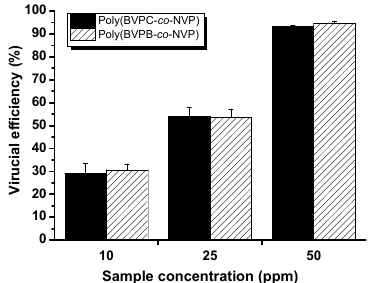
Figure 6. Virucidal efficiency of poly(BVPC- co -NVP) and poly(BVPB- co -NVP) against influenza virus. The result of plaque assay indicated quaternized pyridinium-type polyvinylpyrrolidone possessed highly antiviral activity against influenza virus. According to the foregoing analysis of structure of enveloped virus, the antiviral mechanism of prepared polymers was deduced to be similar to their antibacterial mechanism. The proposed sequence of events with influenza virus exposed to polycations is schematically illustrated in Figure 7. Polycations adhered to influenza virus via strong adsorption to the lipid envelope surface. Subsequently, disorganization and severe damage of lipid envelope occurred due to the interaction between the polycations and viral particles. This resulted in the leakage of the viral genome and consequent deactivation of the virus.